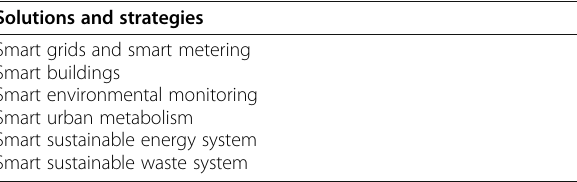
Table 5 The key solutions and strategies of the environmentally